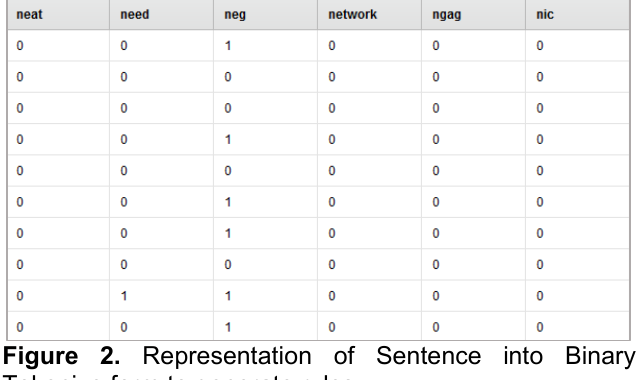
Figure 2. Representation of Sentence into Binary